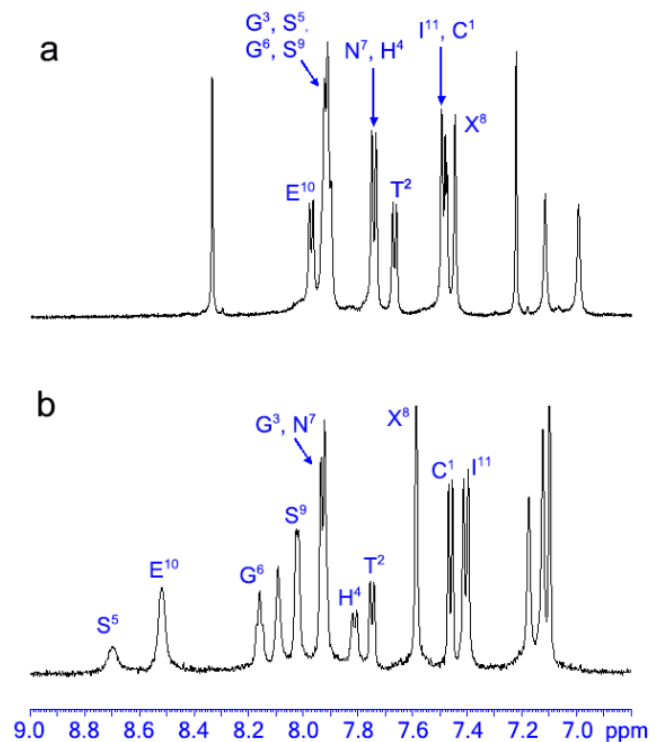
Figure 5. Amide proton region of the 1D 1 H NMR spectra of: ( a ) fully reduced METP3 ( b ) Zn(II)- METP3 complex. Both samples were prepared in CF 3 CD 2 OH.